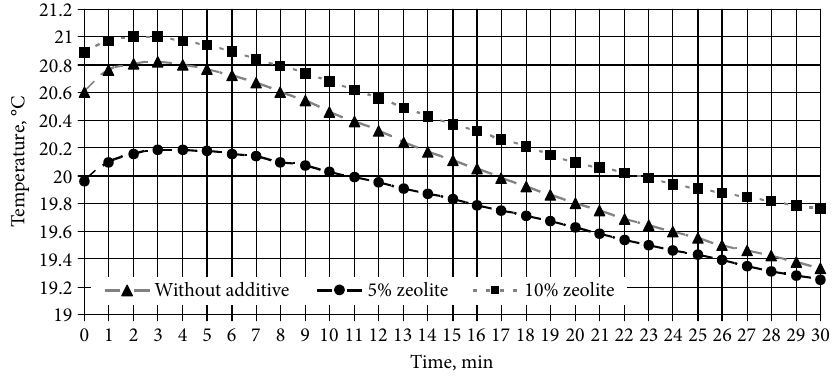
Fig. 4. Temperature changes in cement paste, °C